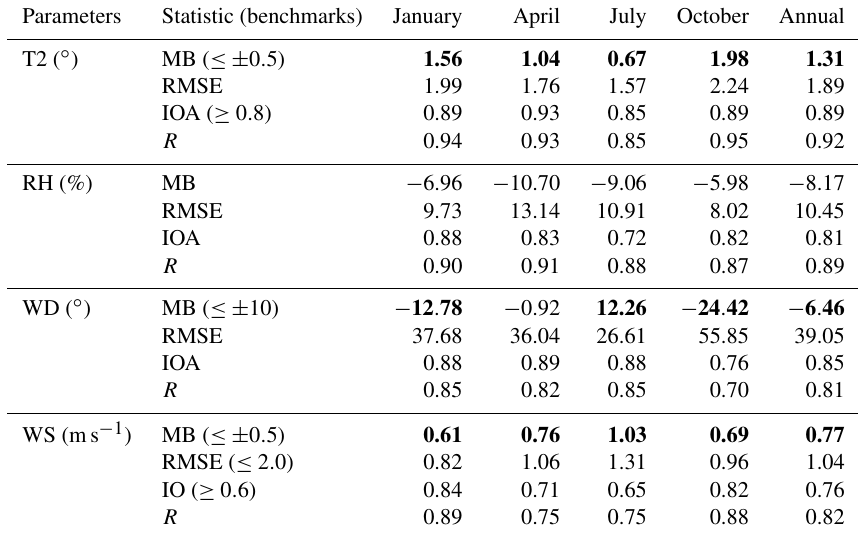
Table 1. Model performance for meteorological parameters for January, April, July, October and the annual average of 2017 in the entire YRD region. The values that do not meet the criteria are denoted in bold. The equations for MB, RMSE, and IOA are defined in Table S4. The benchmarks are suggested by Emery and Tai